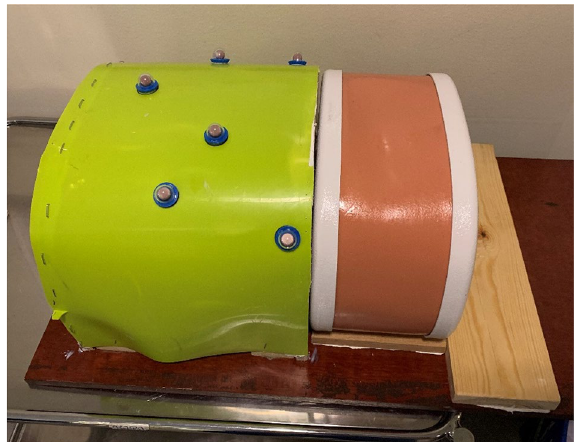
Figure 1. The phantom to the right with the simulated thorax to the left with the skin markers